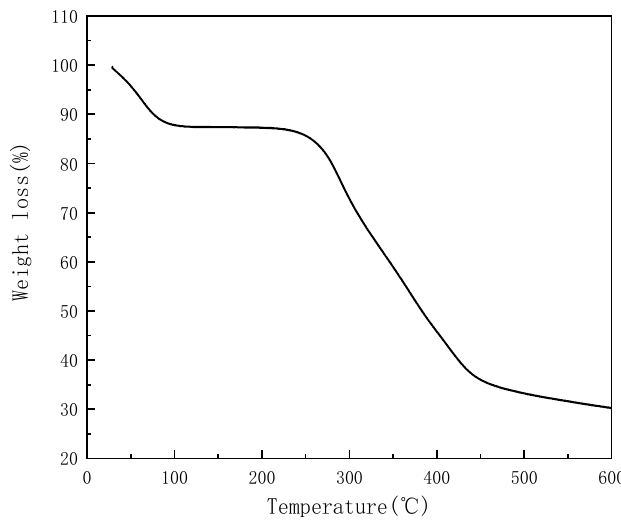
Figure 6. Thermogravimetric curve of γ -Fe 2 O 3 @GMA@IM.